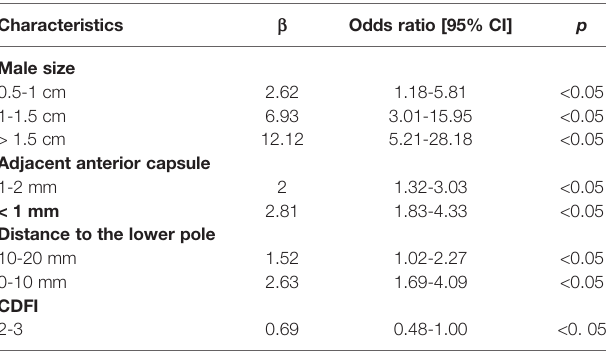
TABLE 3 | Multivariate logistic regression analysis of risk factors for male. Characteristics